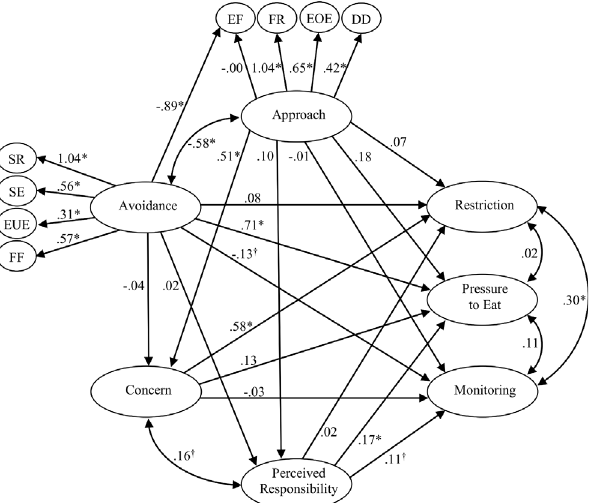
Fig 2. A structural equation model of child eating behaviors and parental feeding practices. The model shows associations between child Food approach and Food avoidance (measured with the Child Eating Behavior Questionnaire) and parental Restriction, Pressure to eat, and Monitoring, with Concern and Perceived responsibility (measured with the Child Feeding Questionnaire) as mediators. The effects (standardized) are adjusted for the effects of child age, gender and body mass index standard deviation score and for parental age, gender, body mass index, foreign origin (Nordic/non-Nordic) and education level (University degree or not) as well as for parental life-style specific Confidence (measured with the Lifestyle Behavior Checklist ’ s Confidence scale). The model shows mediocre fit to data, χ 2 (2718) = 5072, p < 0.001; TLI = 0.878; CFI = 0.885; RMSEA = 0.043 (90% CI: 0.041 – 0.044); SRMR = 0.07. † p < 0.05; * p <